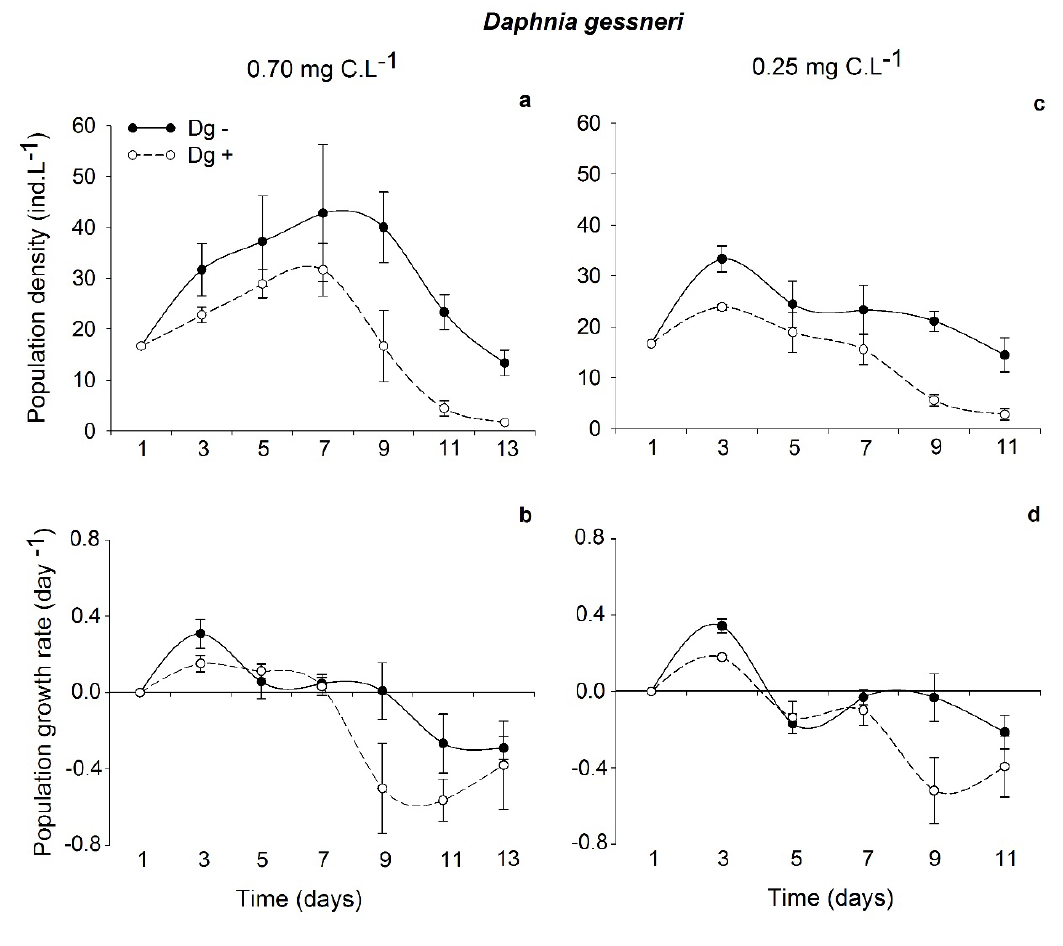
Figure 7. Population growth curves (a, b) and population growth rate (r) per day (c, d) of D. gessneri alone (Dg-) and cultured together (Dg+) in high (0.70 mg C.L -1 ) and low (0.25 mg C.L -1 ) food concentrations, respectively. The vertical bars represent the standard error of the mean (±) based on three